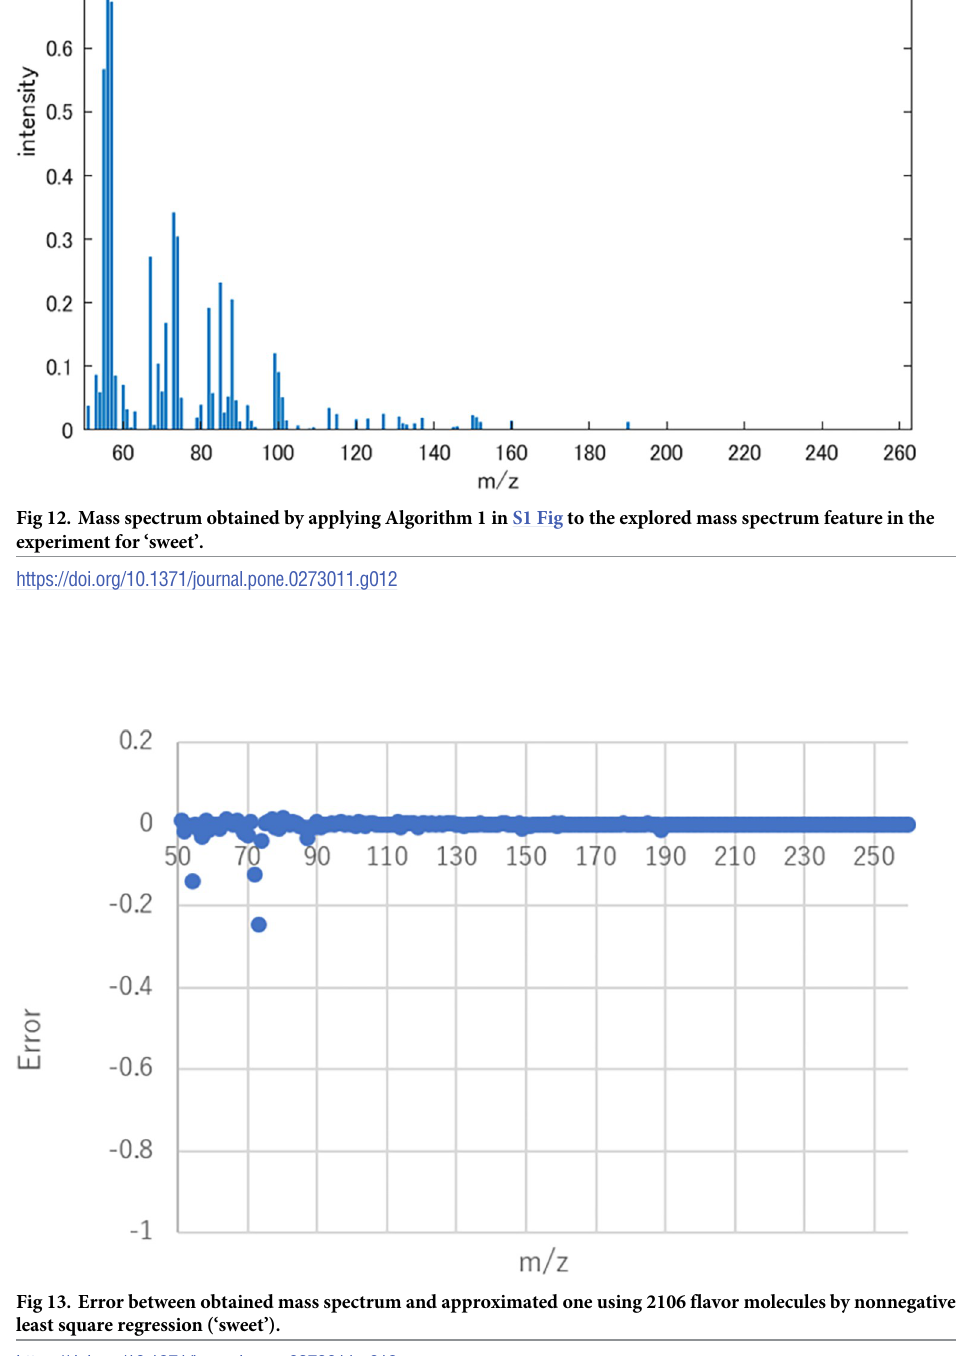
PLOS ONE | https://doi.org/10.1371/journal.pone.0273011 August 17,